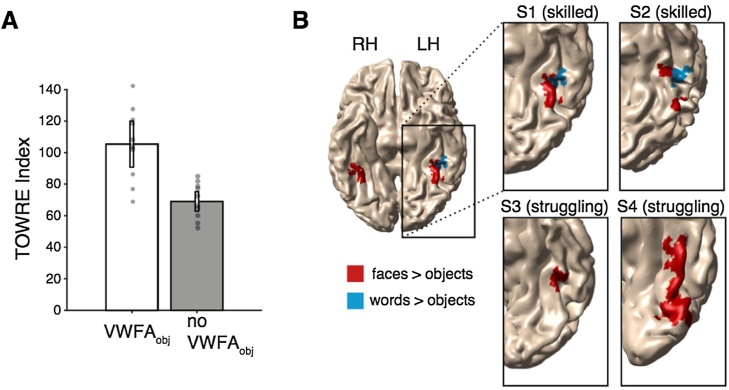
Only skilled readers have a region responding to words over objects. (A) Reading skill in subjects with and without VWFAobj. Reading skill is indexed by the TOWRE index (standard score; M = 100, SD = 15). Y-axis represents the mean TOWRE index within each group. Subjects with a VWFAobj (n = 10) are significantly stronger readers than those without a VWFAobj (n = 10) (p = .00,001). The gray data points show each individual’s TOWRE index. The error bars indicate the SEM across subjects. (B) VWFAobj (blue) and face-object (red) ROIs in example subjects. The top and bottom rows show example skilled and struggling readers, respectively. RH: right hemisphere, LH: left hemisphere.